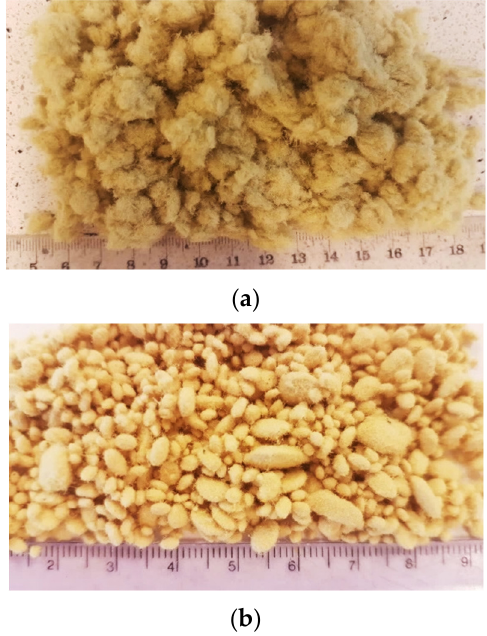
Figure 1. Shredded rock wool ( a ) glass wool ( b ) used for tests.